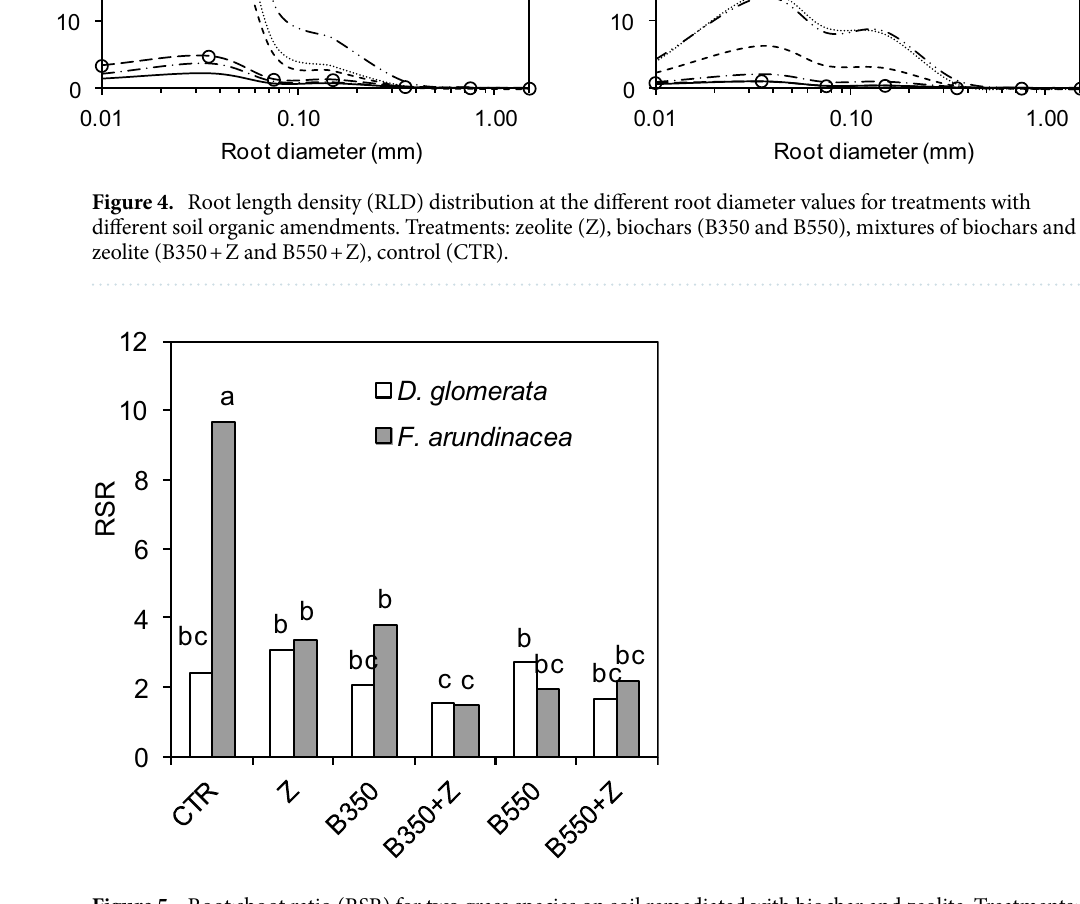
Figure 5. Root:shoot ratio (RSR) for two grass species on soil remediated with biochar and zeolite. Treatments: zeolite (Z), biochars (B350 and B550), mixtures of biochars and zeolite (B350 + Z and B550 + Z), control (CTR). Different letters on the bars indicate significant differences by the Bonferroni test ( P < 0.05, n =